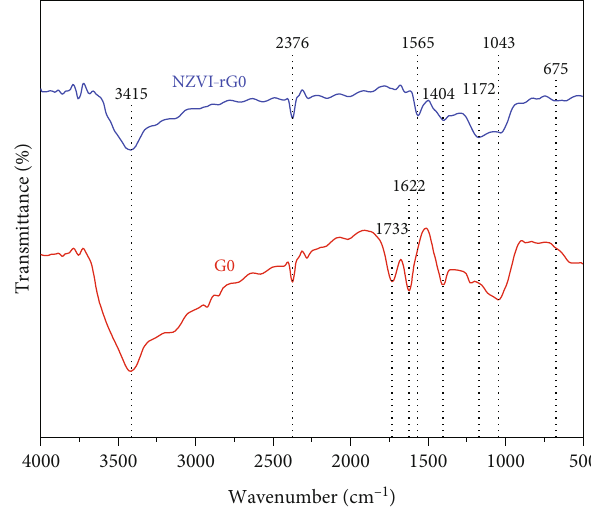
Figure 2: XRD pattern of NZVI-rGO.